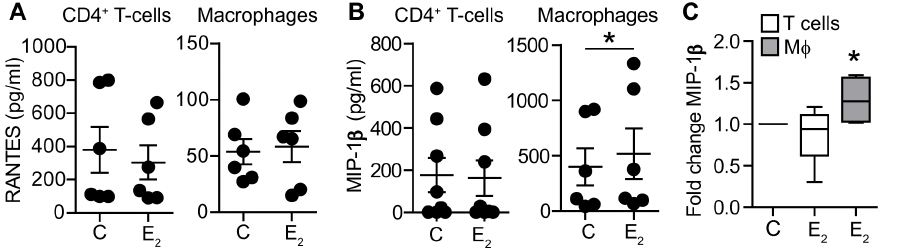
Figure 6. Effect of E 2 on CCR5 ligand secretion. A) Levels of RANTES detected in the culture media from CD4 + T-cells (N=6) and macrophages (N=6) 3 days after infection with HIV-BaL. B) Levels of MIP-1 b detected in culture media from CD4 + T-cells (N=8) and macrophages (N=6) 3 days after infection with HIV-BaL. Each dot represents a different donor. C) Box plot of normalized levels of MIP-1 b in E 2 -treated CD4 + T-cells (white box) and macrophages (grey box) as compared to the control. Whiskers represent maximum and minimum values. *P , 0.05.